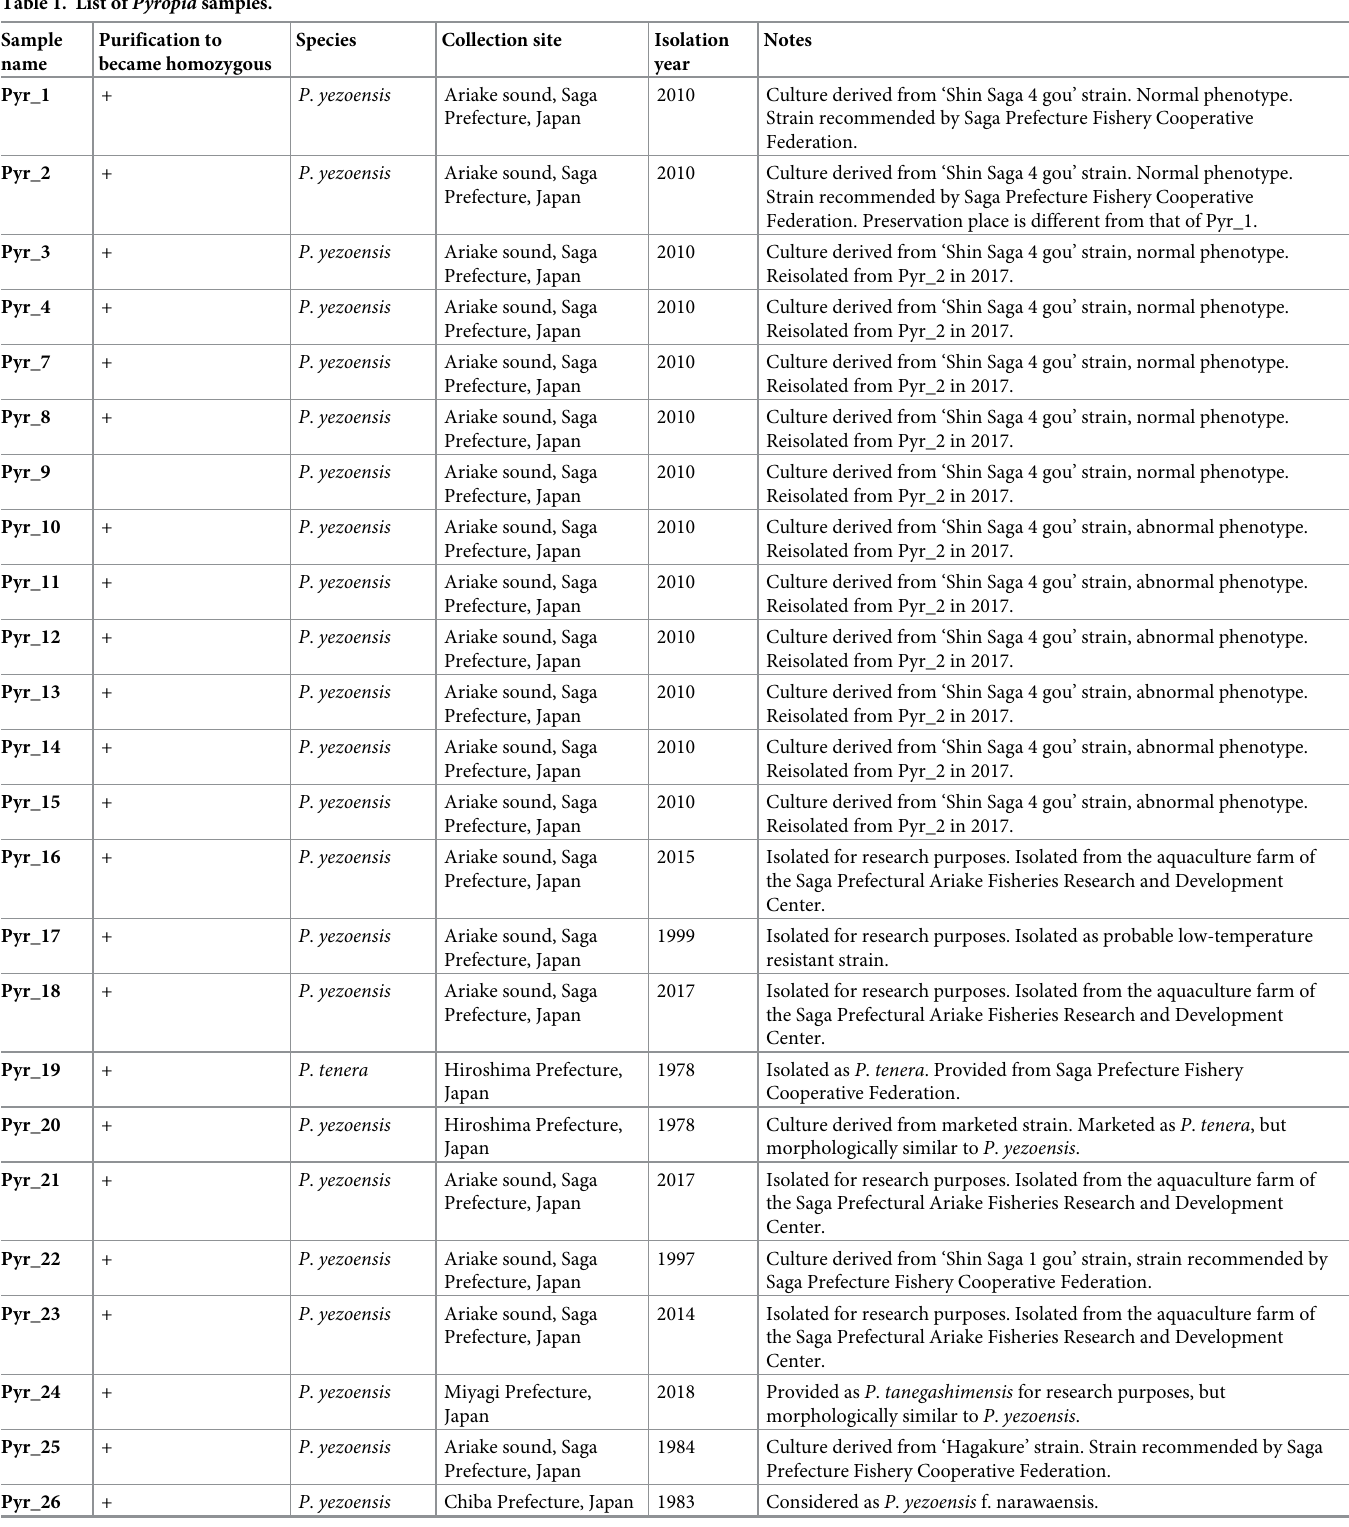
Table 1. List of Pyropia samples. Sample